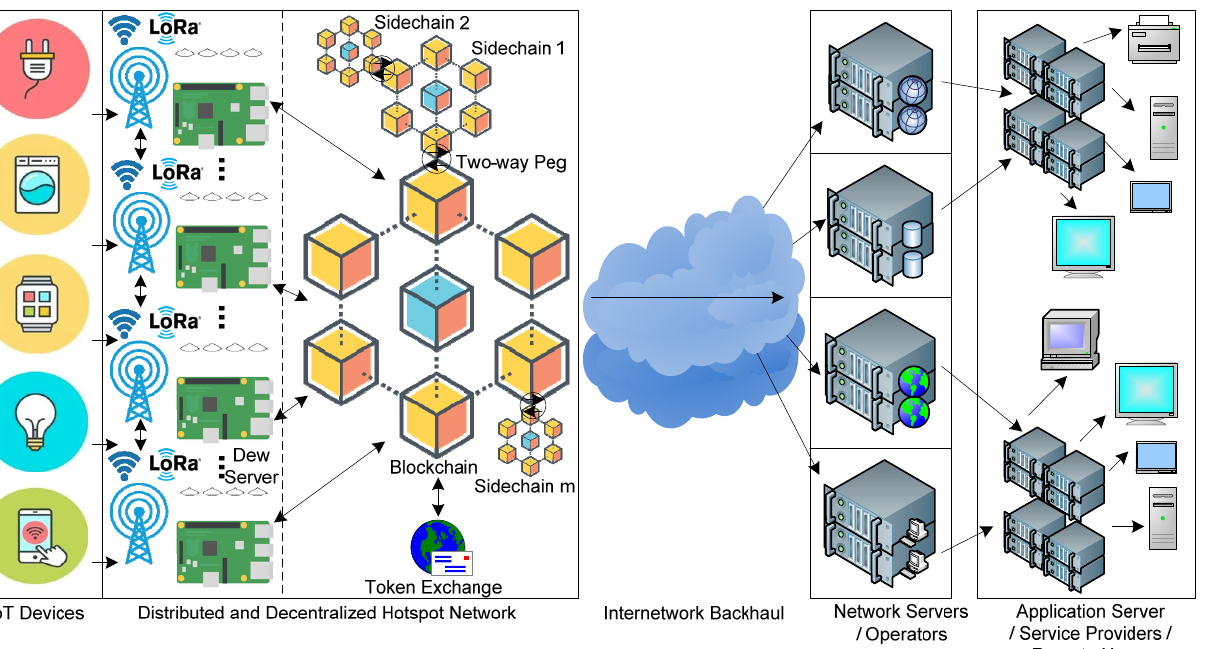
Figure 3. IoT-aware dew computing enabling blockchain-assisted, distributed hotspot network architecture.